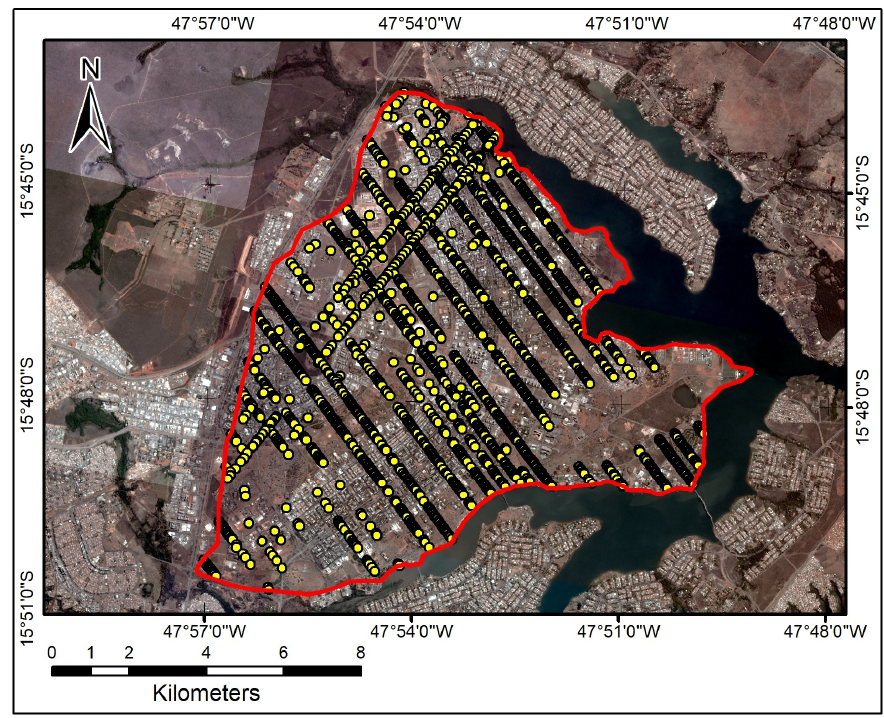
Figure 8. Location of the GEDI samples excluded from <3 to <1 m threshold. The yellow dots are the GEDI samples.